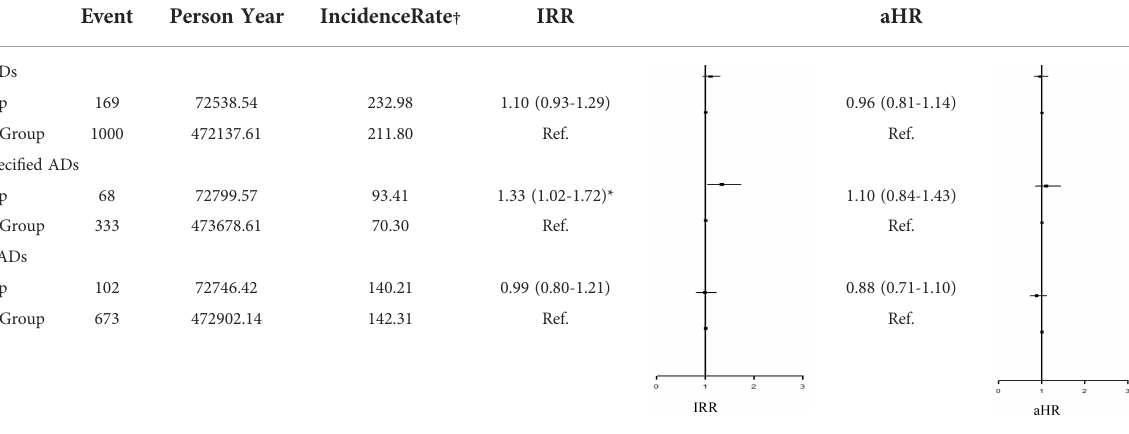
TABLE 2 Incidence Rate Ratio and Hazard Rate of the Risk of ADs between IBT and non-IBT group.